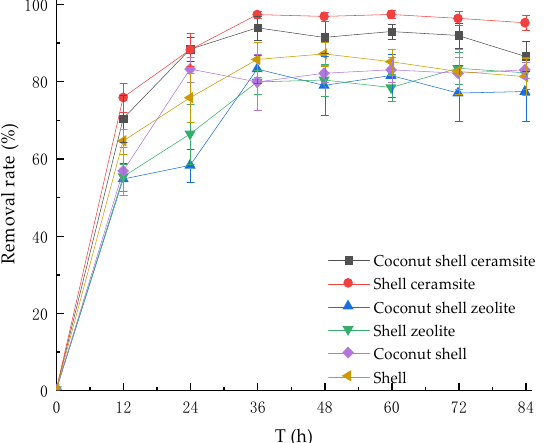
Figure 3. Removal effect of chemical oxygen demand (COD) in biochar-constructed wetlands.